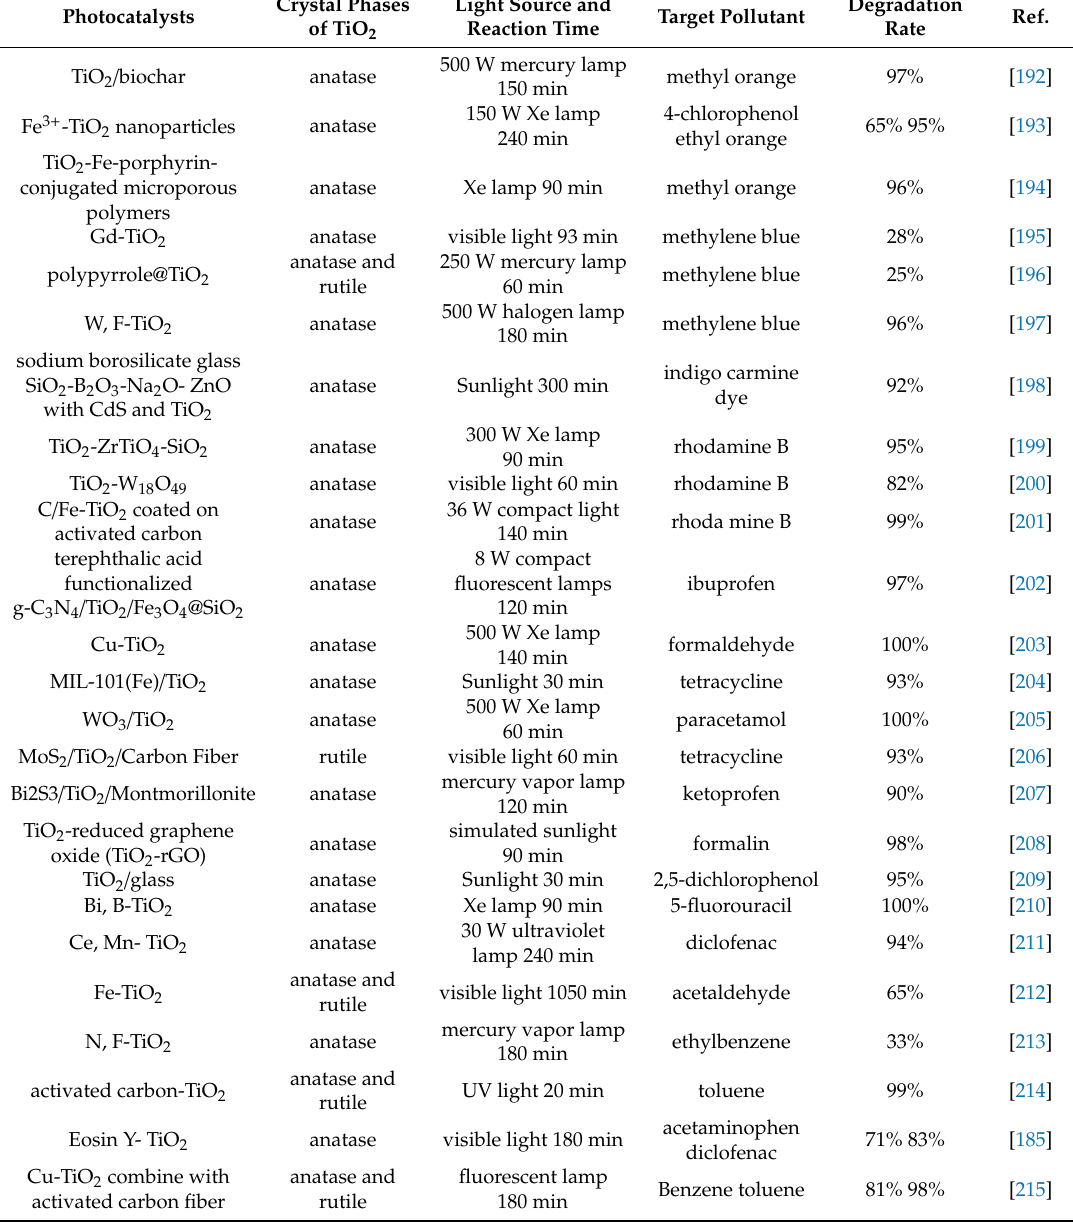
Table 3. The performance of the modified TiO 2 in treating